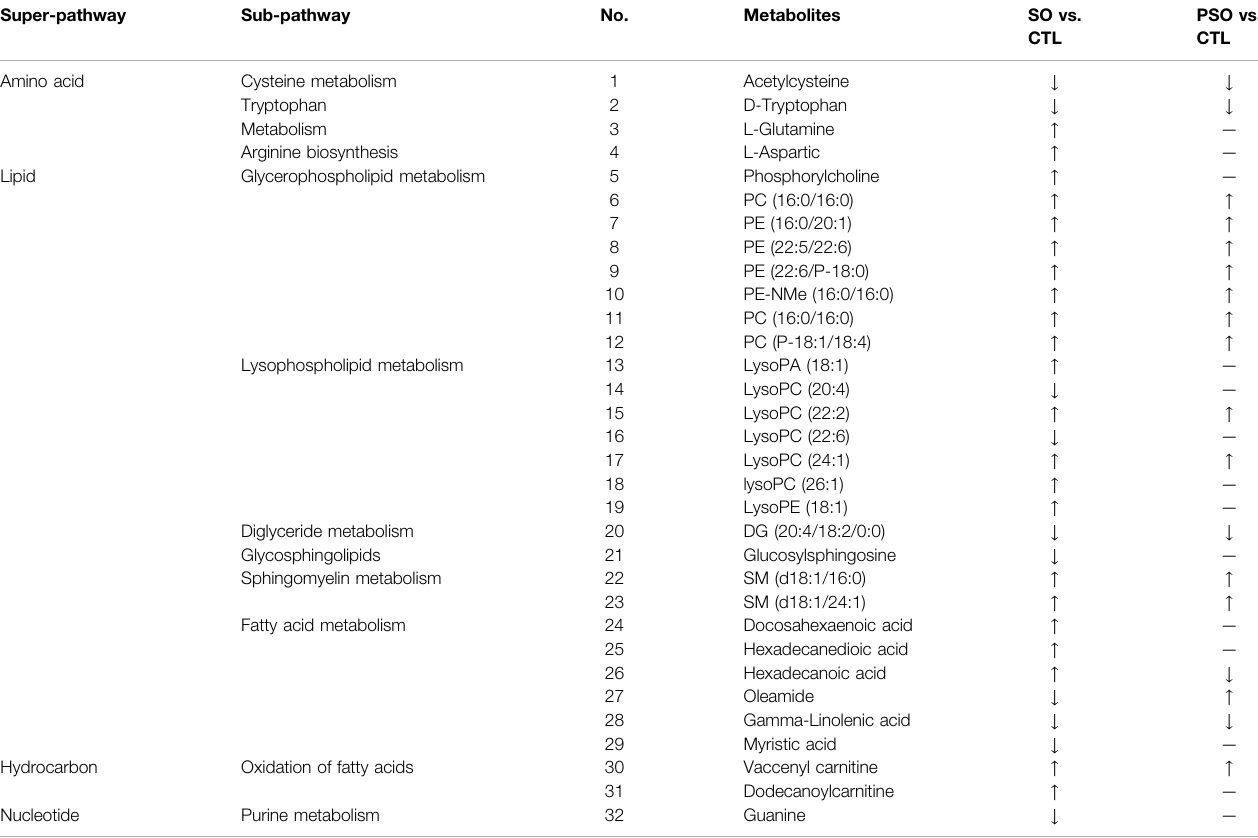
TABLE 1 | Signi fi cantly altered metabolites in the serum samples of vehicle-, raw SO- and PSO-treated rats. ↑ : upregulation; ↓ : downregulation; — : no signi fi cant change. Super-pathway